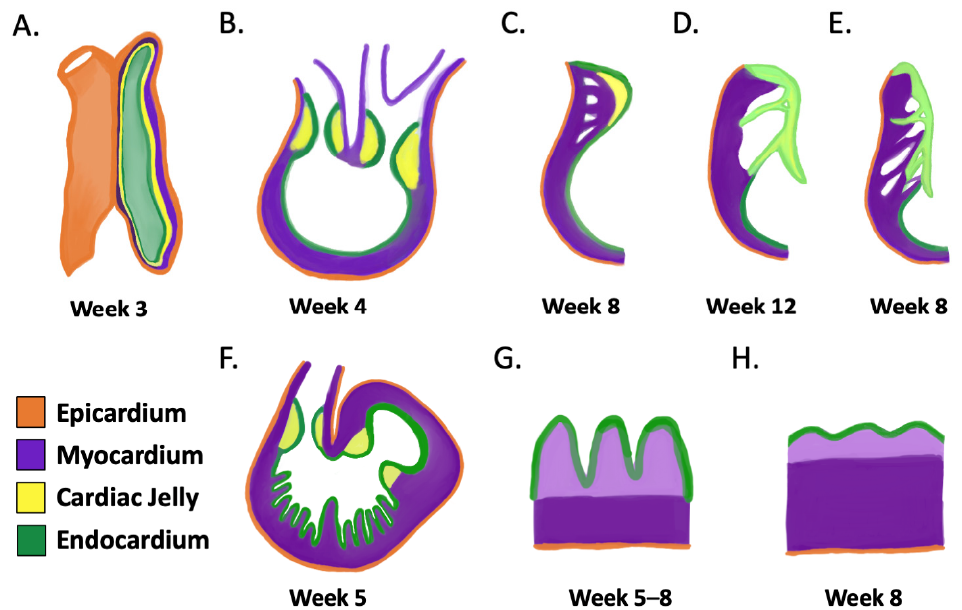
Figure 3. Development of the tricuspid valve and compaction of the ventricular myocardium: Car- diogenesis is initiated as ( A ) heart tube consisting of an outer epicardium that surrounds a layer of myocardial cells, with inner cardiac jelly and an endocardial cell layer; ( B ) following, the heart tube undergoes rightward looping, and endocardial cells overlying the primitive valve regions undergo endothelial-to-mesenchymal transformation and invade the cardiac jelly to form swellings termed endocardial cushions; ( C ) these cushions then remodel and elongate into leaflets/cusps and sup- porting structures. In the atrioventricular position (mitral, tricuspid), the leaflets separate from the myocardial wall via delamination and ( D ) become freely movable; ( E ) an example of an apically displaced valve leaflet with incomplete separation from the myocardial wall typically seen in EA; ( F ) cardiomyocyte proliferation and endocardial cell invagination form the sheet-like protrusions of the ( G ) trabecular layer seen in light purple; ( H ) later, this trabecular layer becomes compacted. Parallel signaling from TGF- β /Smad, Wnt/ β -catenin, noncanonical Wnt, Notch, and Smad-inde- pendent TGF- β , BMP, and FGF pathways enable the development of both the tricuspid valve and compaction of the ventricular myocardium. Time indicated corresponds with human development. The tricuspid valve is comprised of anterior, septal, and posterior leaflets; delamina- tion of the septal leaflet from the muscular ventricular septum [116,117] likely occurs via anoikis (integrin-mediated apoptosis) [115]. Failure of delamination is thought to result in EA, which is characterized by an apically displaced tricuspid valve with a varied degree of freedom in movement (Figure 3E). As these events unfold, myocardial compaction of the trabeculae, which began form- ing in week 4, occurs in week 8 [110,118]. As the myocardium expands via cardiomyocyte proliferation, endocardial cells invaginate, forming sheet-like protrusions (Figure 3F,G) comprising the trabeculae (light purple in Figure 3G), which is theorized to facilitate ex- change of oxygen and nutrients [14]. By mid-gestation, the trabeculae become compacted (Figure 3H) [8,119]. Important factors in early trabeculation are a result of signaling via endocardial and myocardial Notch, myocardial BMPs, epicardial FGFs, and both canoni- cal and noncanonical Wnts [14].